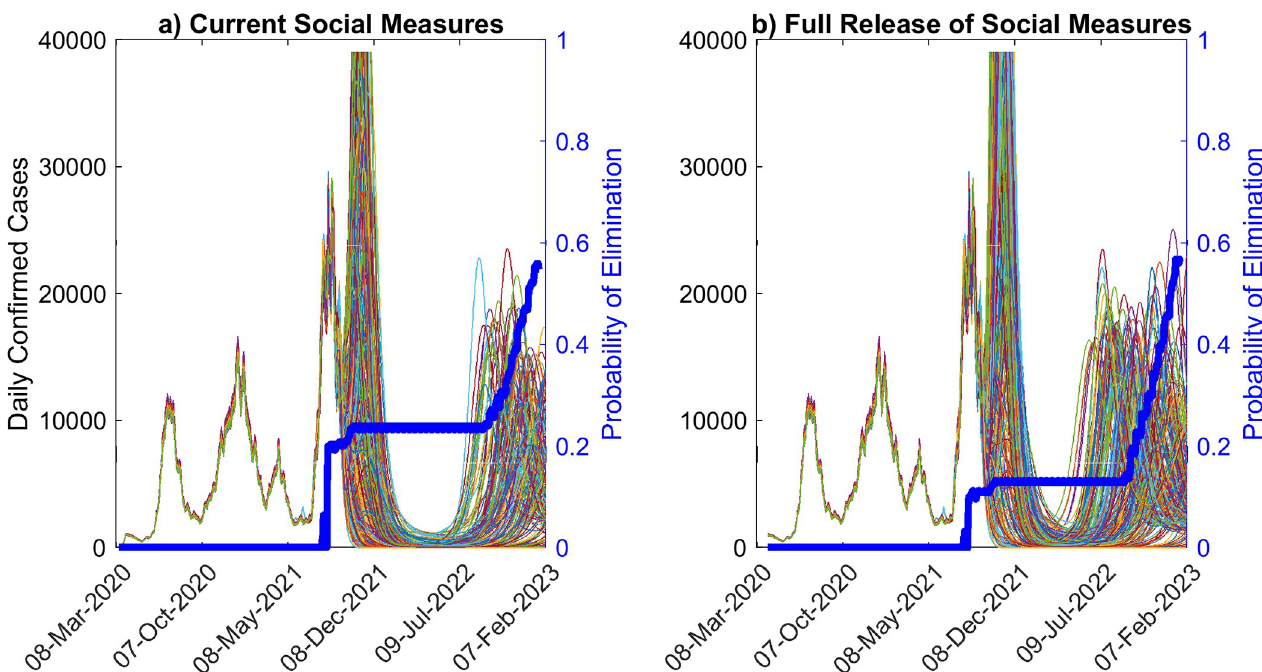
Fig 6. Model ensemble and probability of elimination over time, given waning of immunity. Ensemble of predictions of daily confirmed cases, and probability of elimination over time, assuming waning of natural immunity over 2.5 years, given a) estimates of social measures as of Sept. 24 th 2021 and b) after the full release of social measures. The predictions of the model ensemble (250 in total, see Methods) are represented by the thin curves in the background of the figure. For the estimated social measures and vaccination rate, the probability of fadeout is given by the blue curves. For these scenarios, the probability of elimination does not reach 50% until